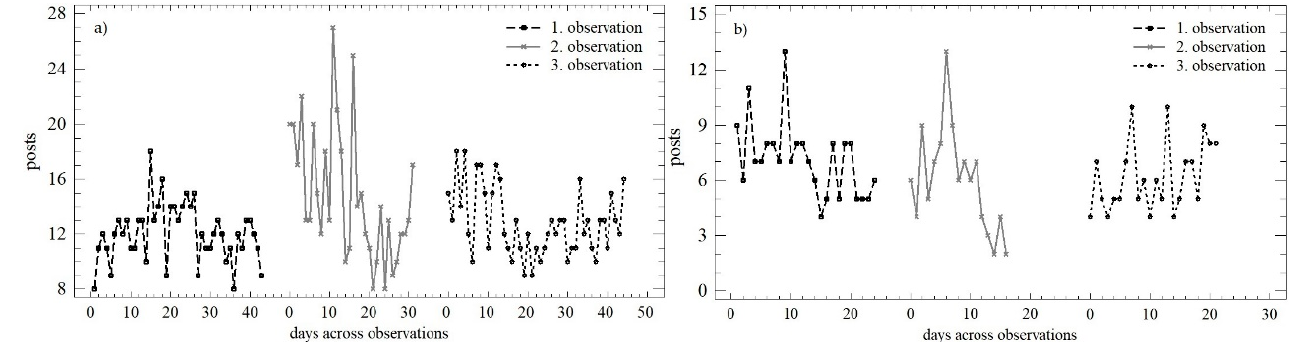
Figure 2. Scatterplot of the numbers of posts across observation periods: ( a ) working days; ( b ) week- end.